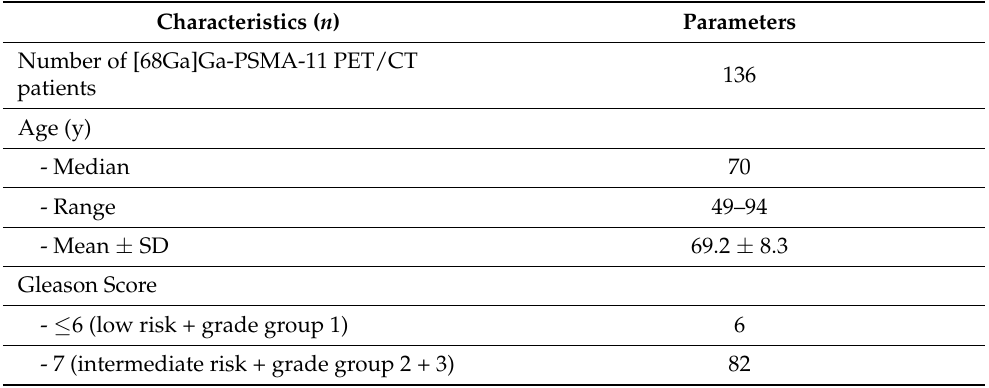
Table 2. Characteristics of 136 patients examined with restaging [ 68 Ga]Ga-PSMA-11